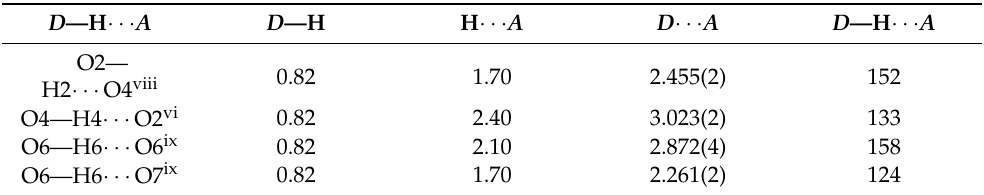
Table 5. Hydrogen-bond geometry with H · · · A < r A + 2 Å ( r A is a radius of an acceptor) and D –H · · · A > 110 ◦